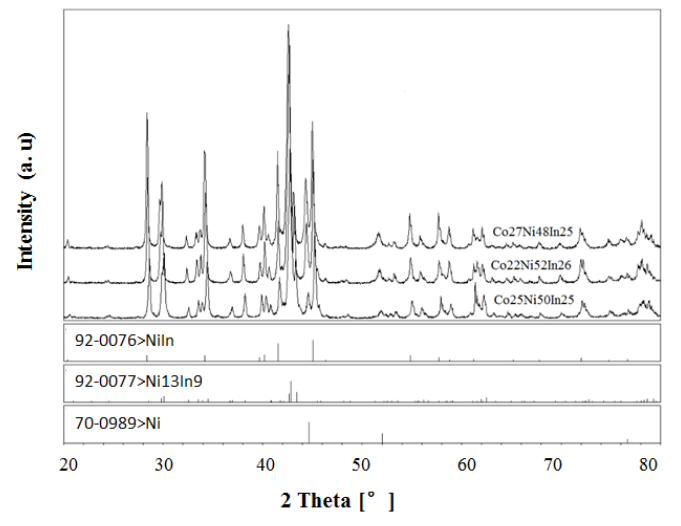
Figure 2. XRD patterns of samples No. 3 (Co25Ni50In25), No. 4 (Co22Ni52In26), and No. 5 (Co27Ni48In25).